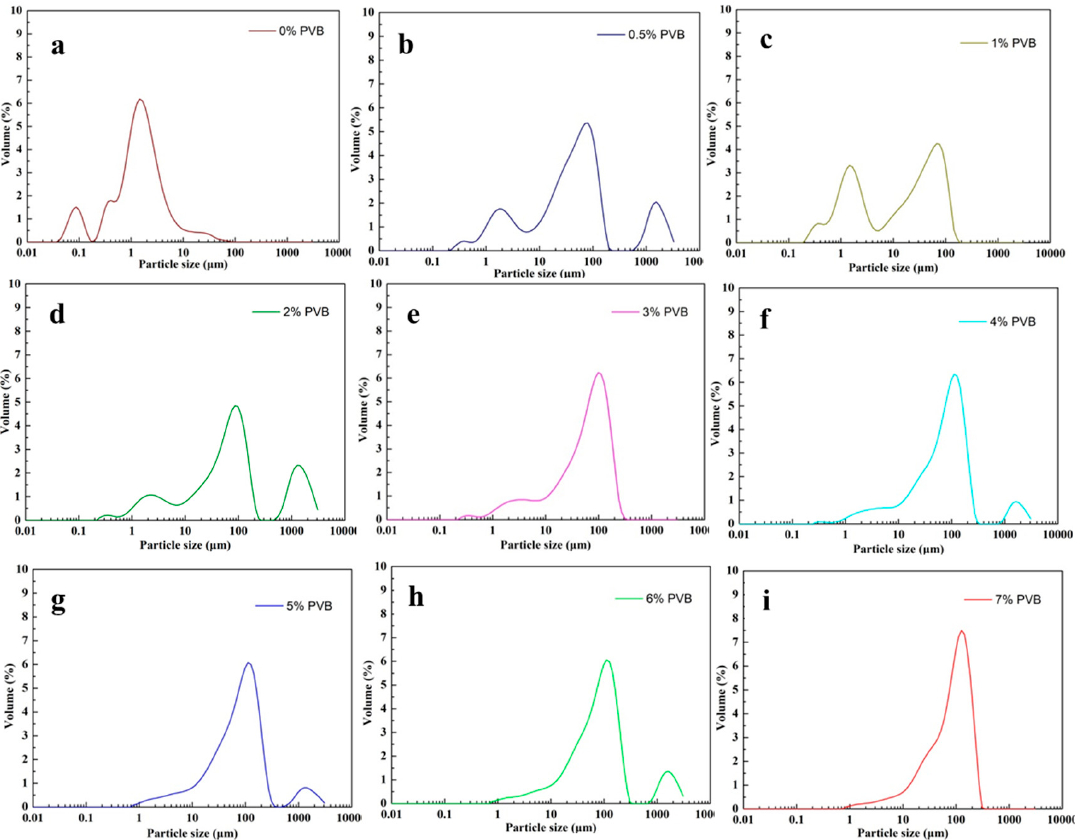
Figure 4. Size distributions of SiC/PVB composite powders with different contents of PVB binder.